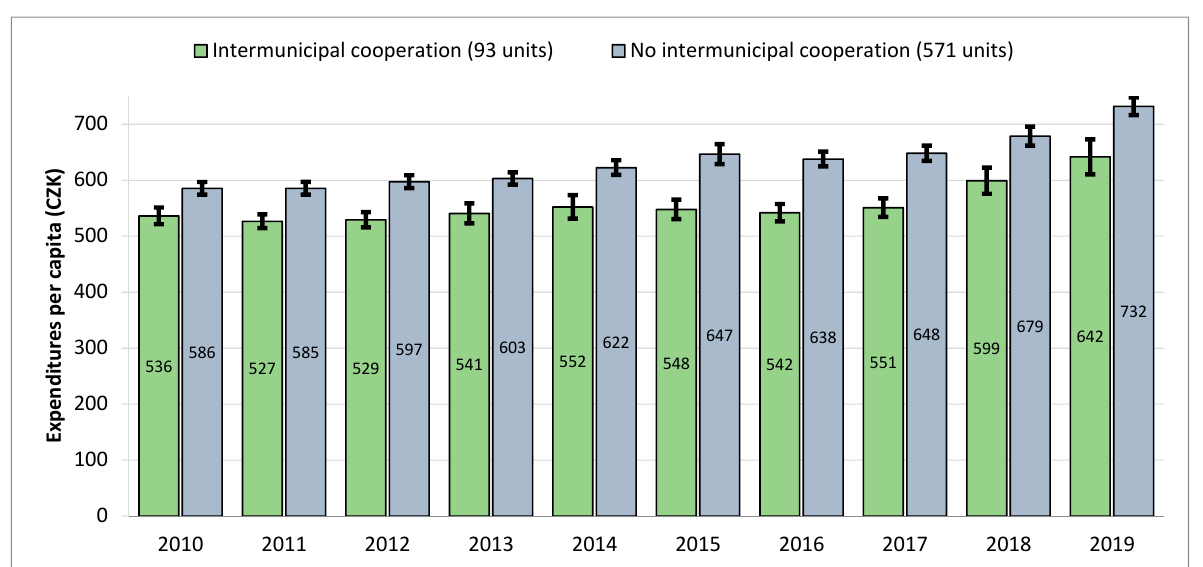
Figure 3. Average MSWM expenditures per capita during 2010–2019, 664 municipalities, standard error of the mean (SEM) bars included.